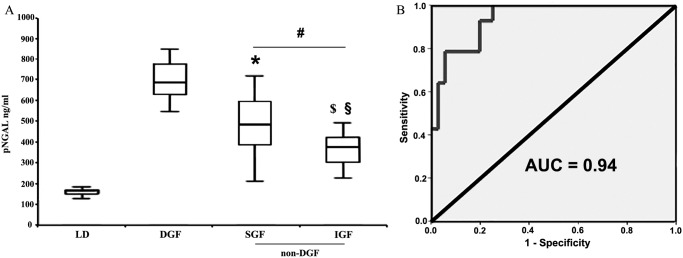
Evaluation of plasma NGAL levels at day 1 after KT in patients subdivided on the basis of graft function (DGF: Delayed Graft Function; SGF: Slow Graft Function; IGF: Immediate Graft Function).(A) NGAL was significantly higher in DGF (662.7 ±97.2 ng/ml, n = 14) vs. non-DGF patients (SGF + IGF: 379.7±139.7 ng/ml, n = 36; #p<0.00001). A statistical significance was also observed comparing DGF vs SGF (444.1±149.5 ng/ml, n = 19; *p<0.001) or IGF (307.8±101.8 ng/ml, n = 17; $p<0.00001) and SGF vs IGF (§p<0.01). NGAL levels of KT from living donors (LD) were used as control. (B) The Area Under the ROC curve (AUC) of NGAL as biomarker of DGF at day 1 post-KT was 0.94.